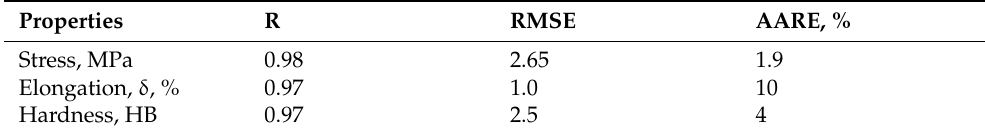
Table 9. The R, RMSE, and AARE (%) of experimental and predicted data of the verification alloys. Properties R RMSE AARE, % Stress, MPa 0.98 2.65 1.9 Elongation, δ , % 0.97 1.0 10 Hardness, HB 0.97 2.5